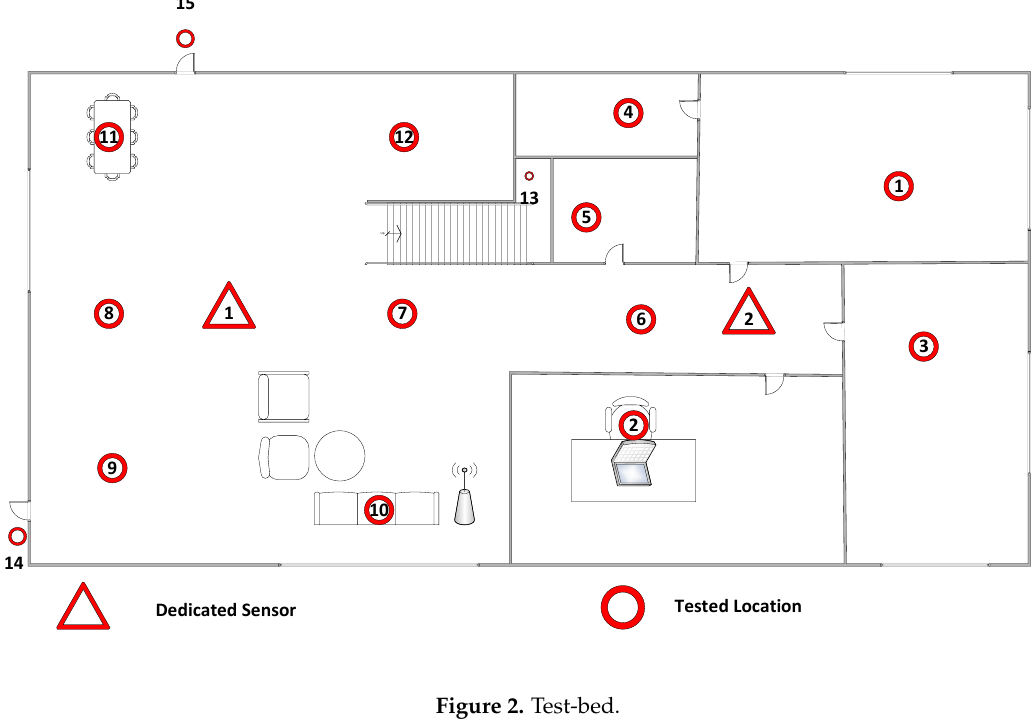
Figure 2. Test-bed.